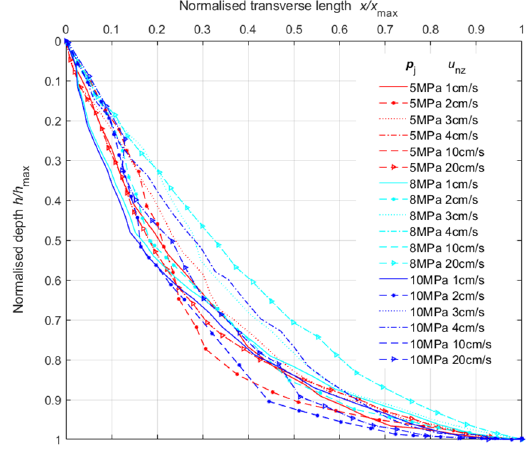
Figure 14. Normalised erosion surface morphology.